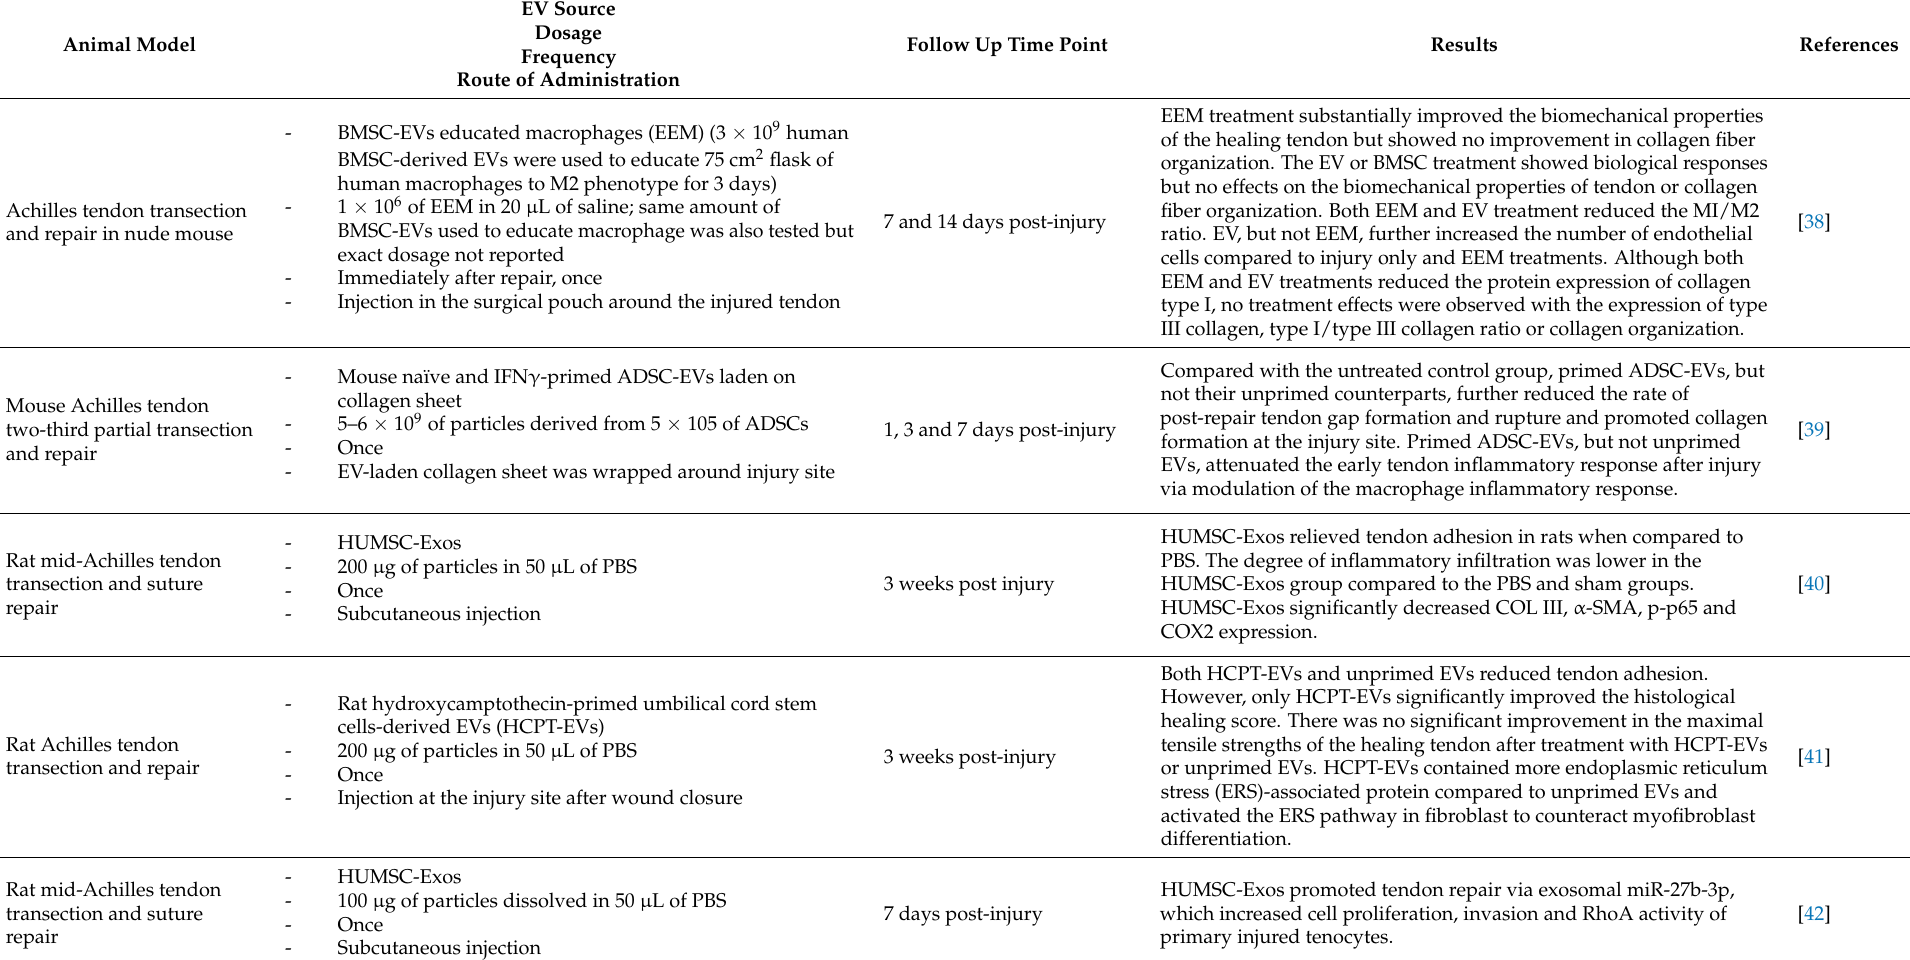
Table 2. Summary of pre-clinical studies investigating the therapeutic effects of MSC-EVs on tendon and ligament repair.